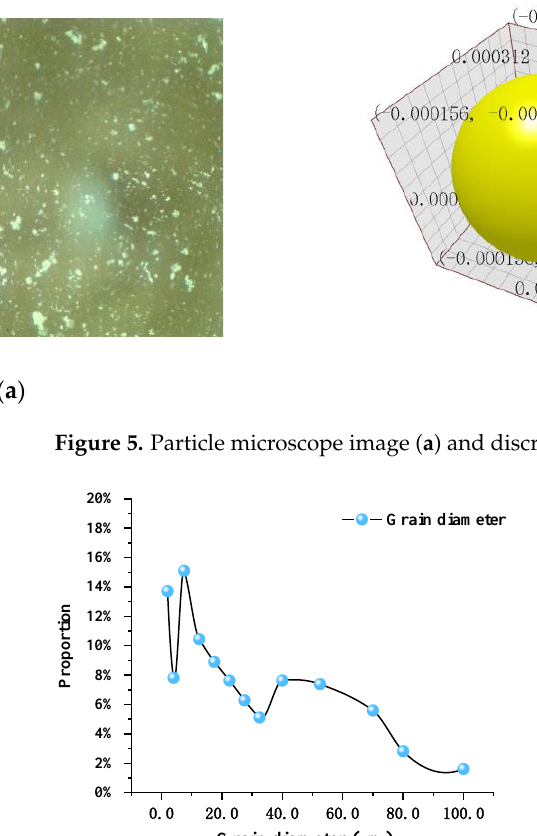
Figure 6. Tailings true particle size distribution map.